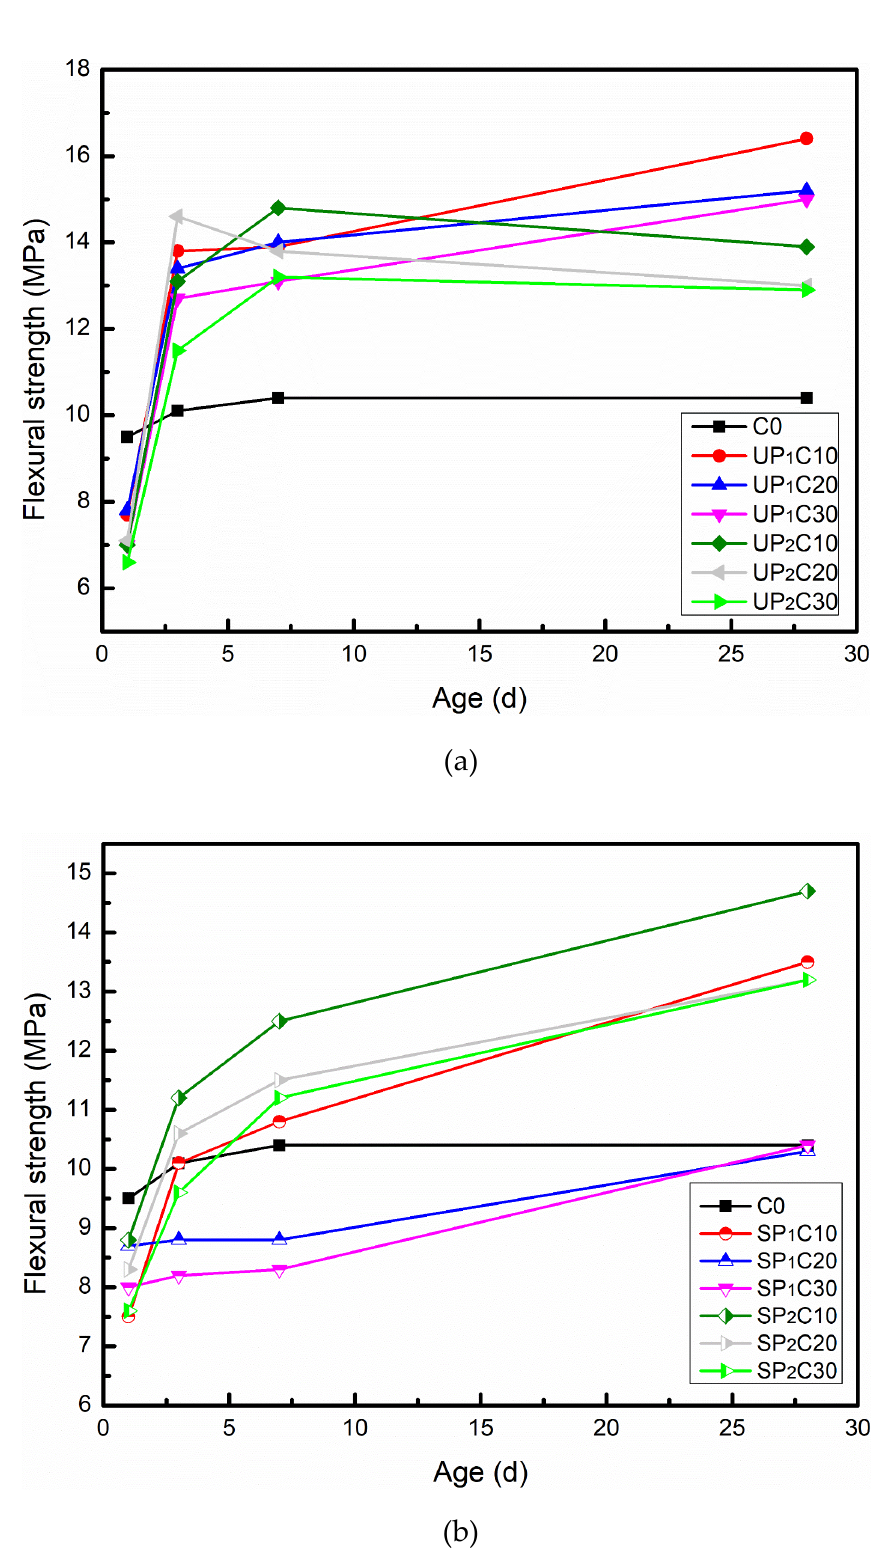
Figure 5. Flexural strength variation of UHPC combined with water absorption pumice: ( a ) unsaturated pumice substitution; ( b ) saturated pumice substitution.